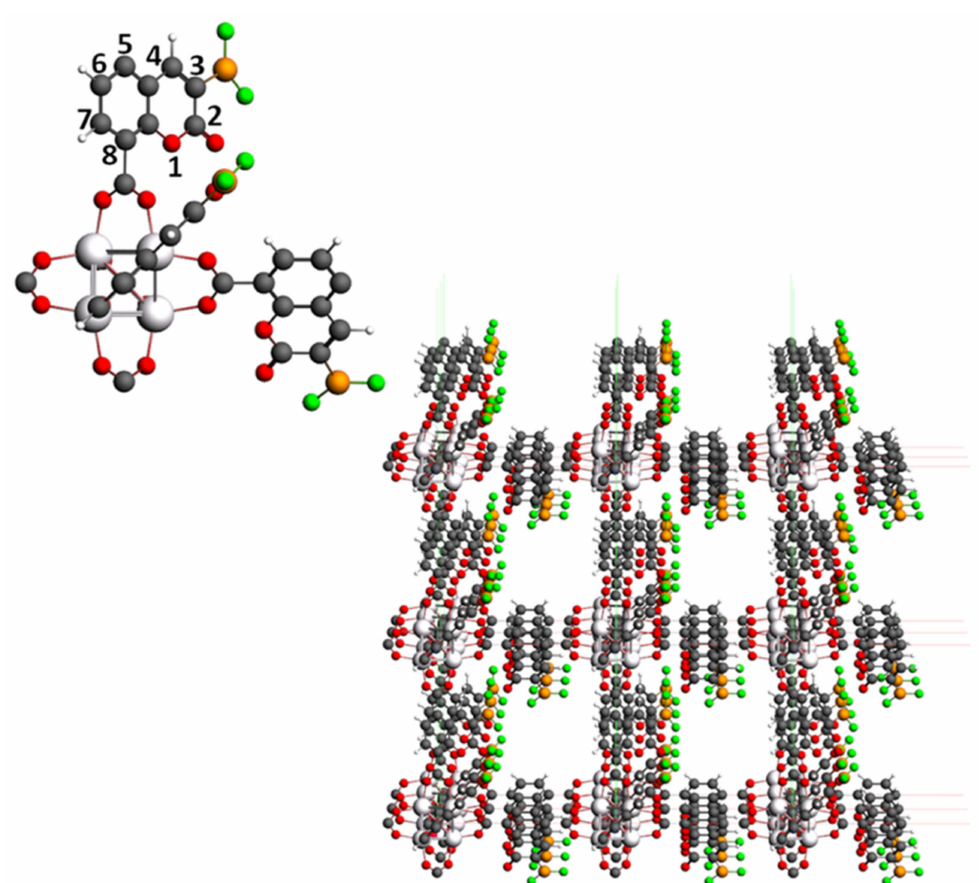
Figure 1. Unit cell of IRMOF-C-BF 2 purposed in this work. The cell’s parameters considered are a = b = c = 12.941 Å and α = β = γ = 90 ◦ . At the left superior corner, primitive cell of IRMOF-C-BF 2 . Coordinates in xyz format are available in the Supplementary Materials (Table